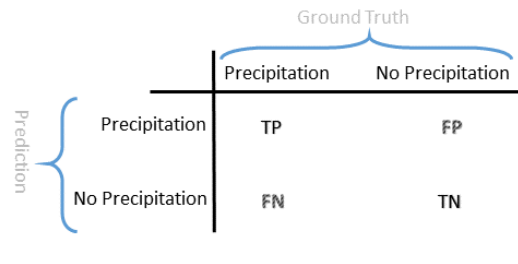
Figure 8. The illustration of confusion